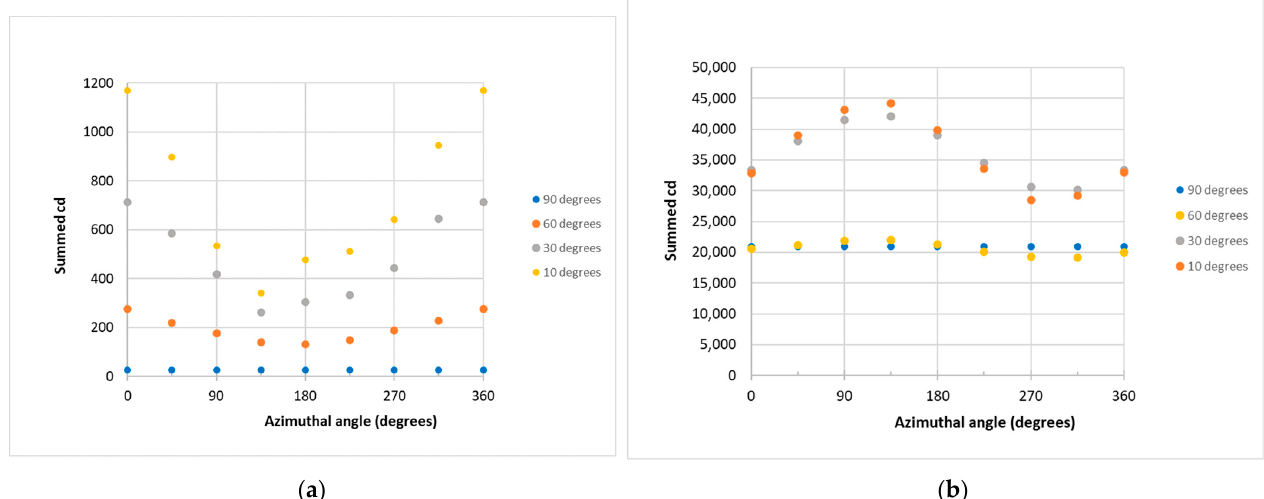
Figure 5. ( a ) The calculated direct emission for Ballindangan for a range of angles and ( b ) the equivalent data for Dublin. In the case of Ballindangan the lighting is predominantly of low pressure sodium type and the radiance towards low angles is larger than that seen when looking straight down on the target area. Note also that the emission differs by approximately a factor of three around the azimuthal direction.